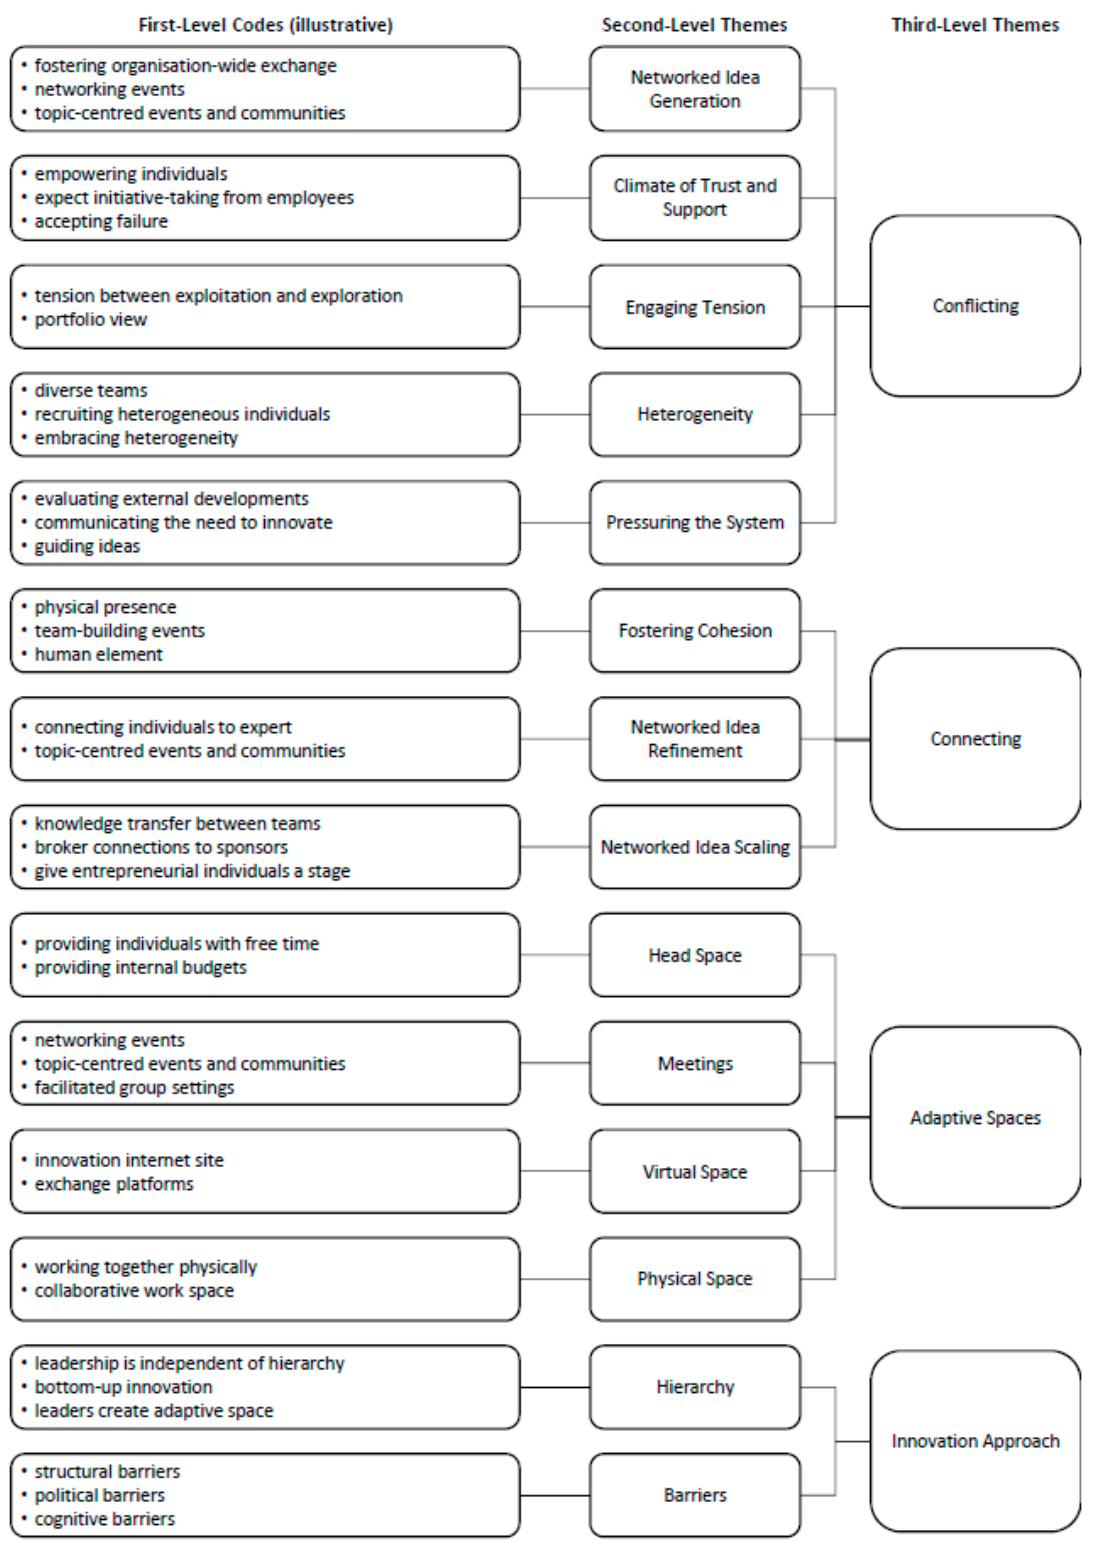
Figure 2. Final coding template.